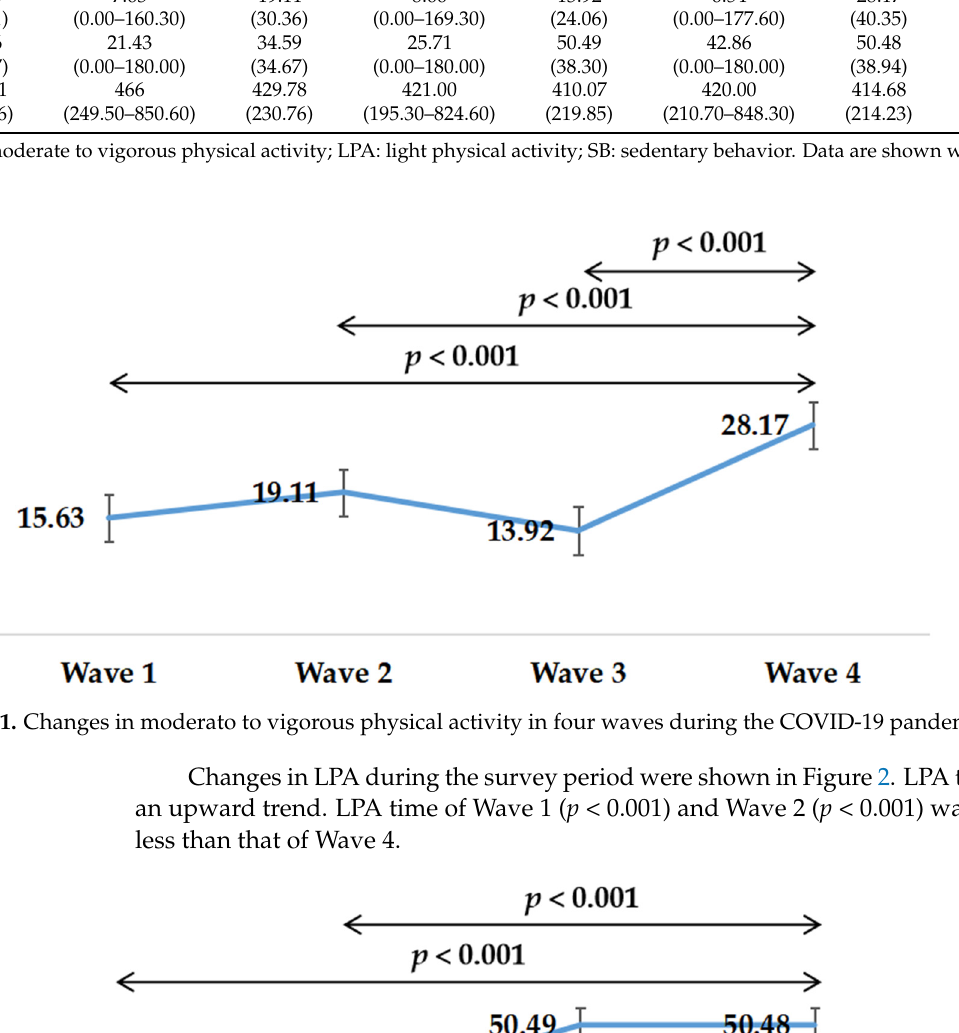
Table 2. Descriptive characteristics of physical activity and sedentary behavior in different waves.